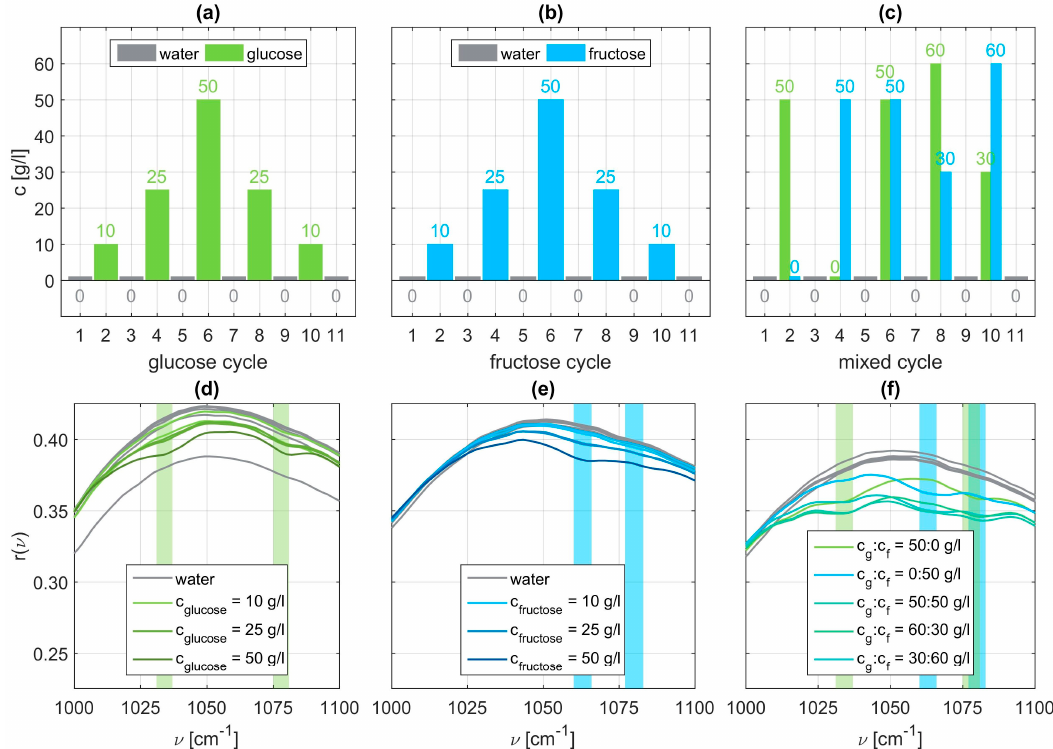
Figure 3. Employed measurement cycles with different concentrations of glucose ( a ), fructose ( b ), or both ( c ). Panels ( d ) to ( f ) show the corresponding relative reflectance of each of the eleven SEIRA measurement sets with the expected fingerprint region for molecular vibrations of glucose and fructose highlighted in light green or light blue, respectively.